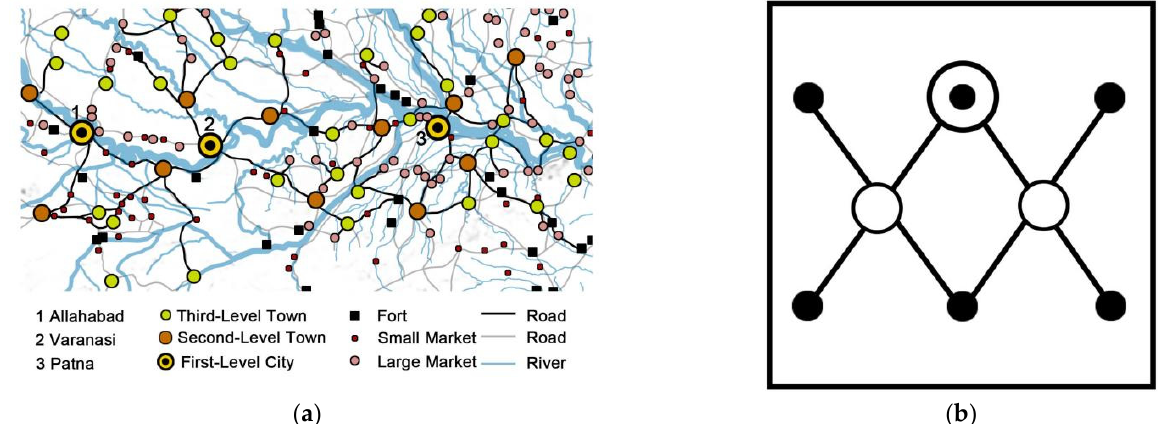
Figure 13. ( a ) Spatial pattern of the city network in the middle Ganga Plain. Source: the authors; Base Map: Google satellite map; Reference: [65]; ( b ) Pyramidal pattern dominated by a political system. Source: the authors.